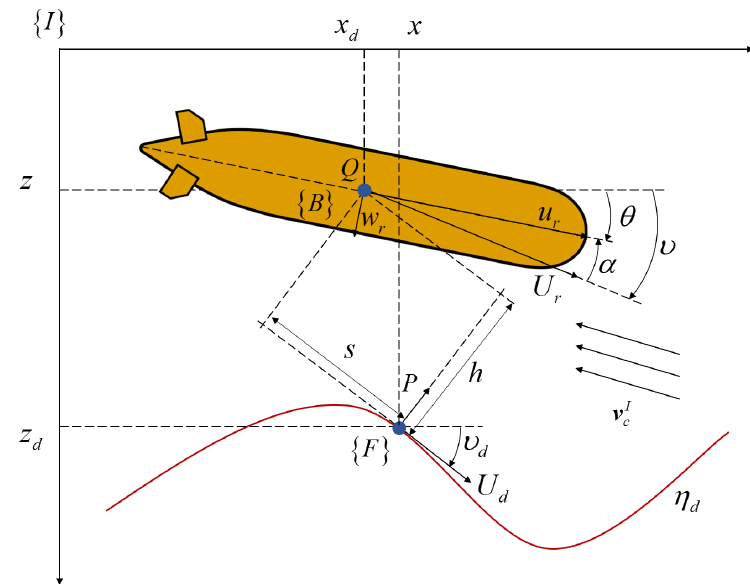
Figure 4. The definitions of trajectory tracking errors in the vertical